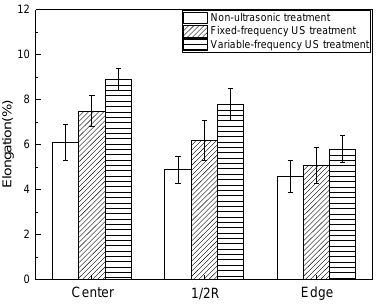
Figure 12. Elongation of ZK60 alloy with different ultrasonic treatments.